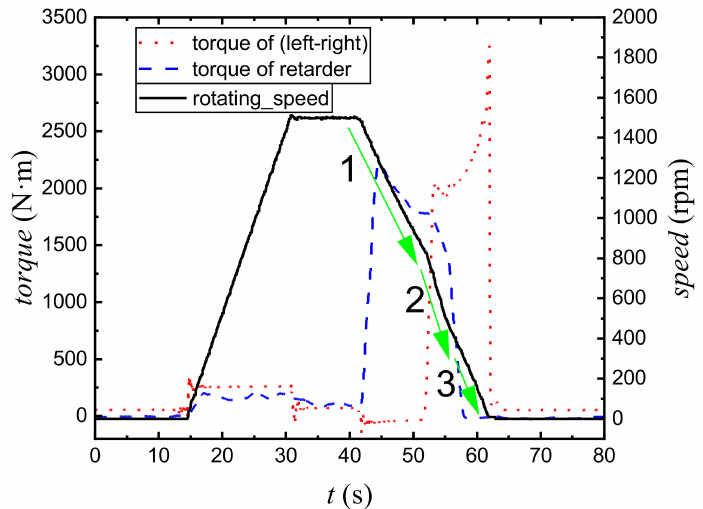
Figure 27. Difference between the left and right torque, retarder torque and capstan speed.